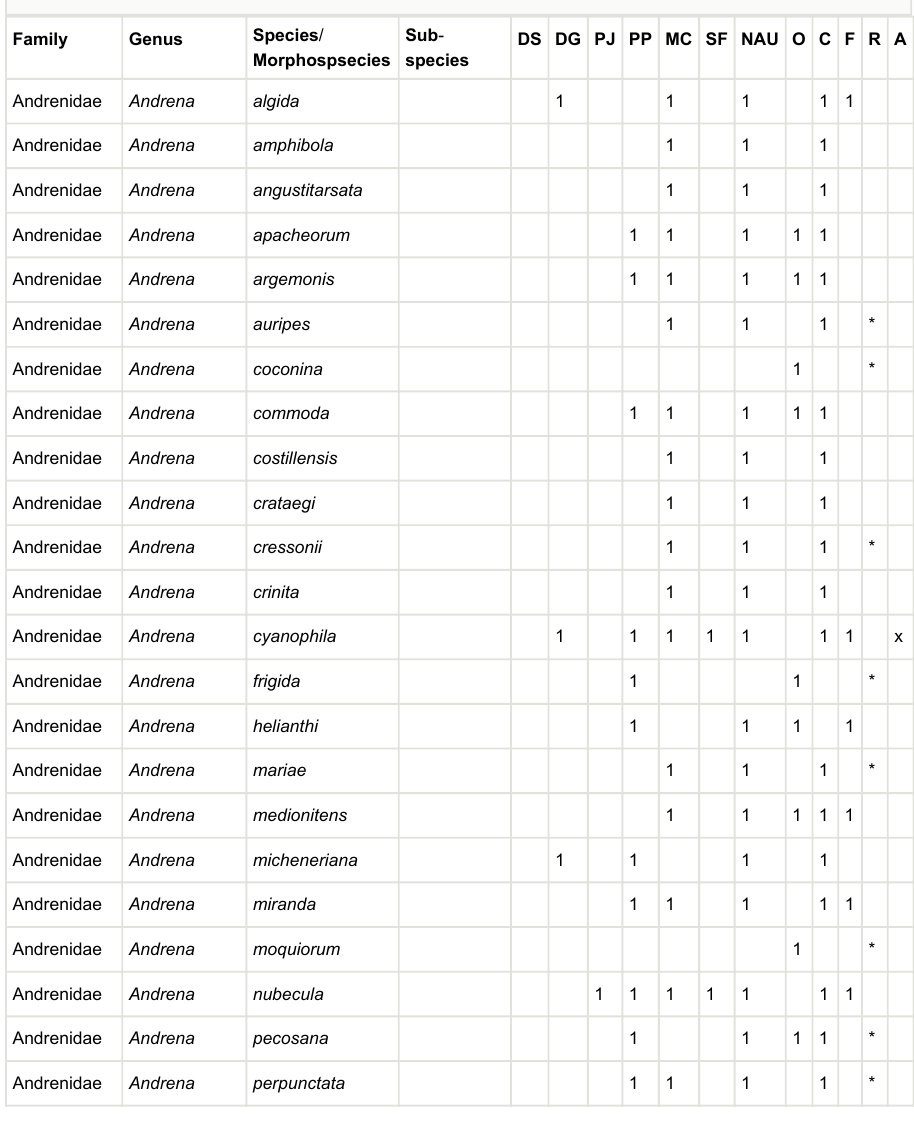
Table 2. Comprehensive list of bee species collected in the San Francisco Peaks region. Each life zone is denoted (DS = desert shrub, DG = desert grassland, PJ = pinyon-juniper, PP = ponderosa pine, MC = mixed conifer, SF = spruce-fir). Notations in the "NAU" column are species that were recorded in the NAU inventory study from 2009–2019. Notations in the "other" (O) column were species recorded to occur on the San Francisco Peaks by other institutions. Notations also designate whether species were collected from cup (C) sampling or flower (F) sampling. Further, rare (R) species (only one specimen collected) are marked with a "*" and abundant (A) species (>100 specimens collected) are marked with an Sub - Family Genus Species / Morphospsecies species